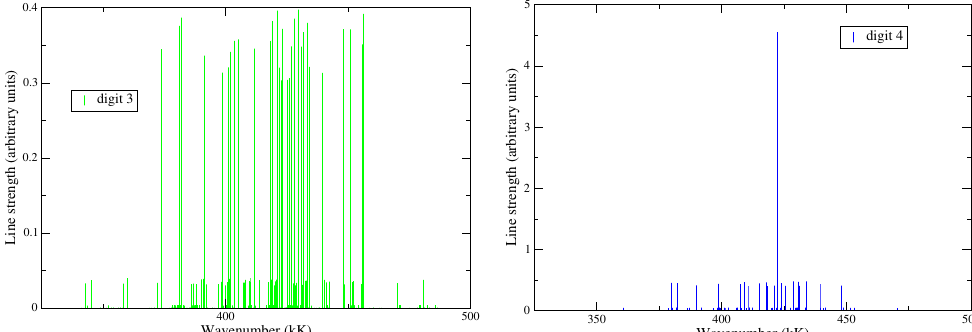
Figure 13. Number of lines with a first significant digit of 3 ( left ) and 4 ( right ) in their strength, as a function of their energy, for transition array 3 d 4